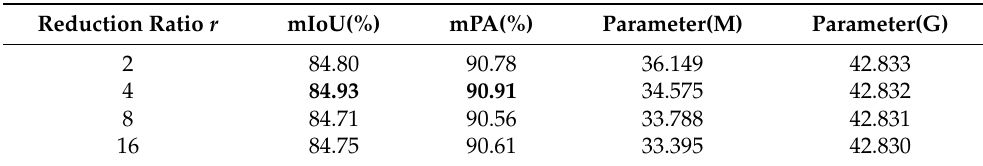
Table 2. It is important to set the appropriate reduction ratio in the Channel Feature Compression (CFC) (bold represents the best result).